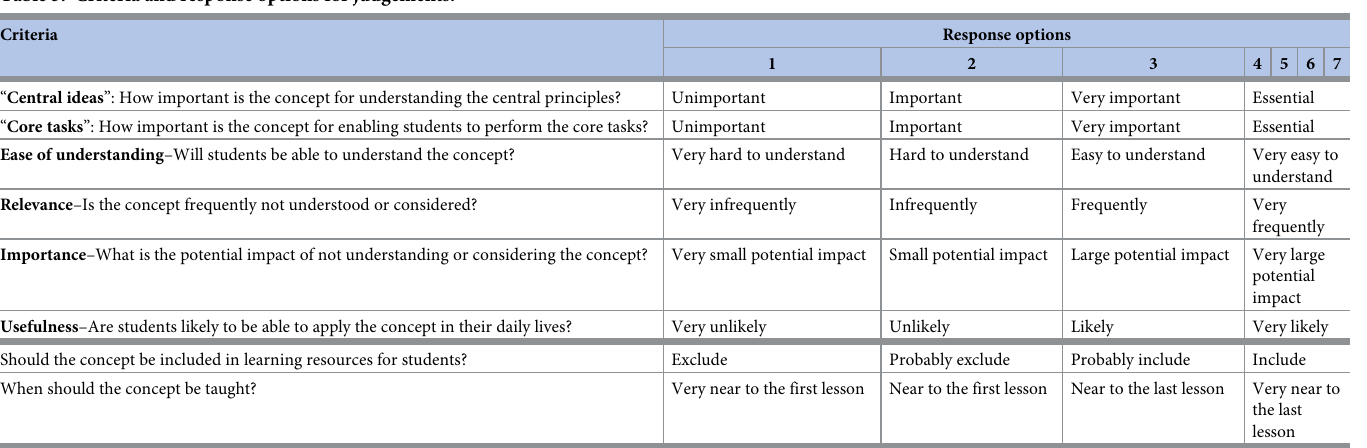
Table 3. Criteria and response options for